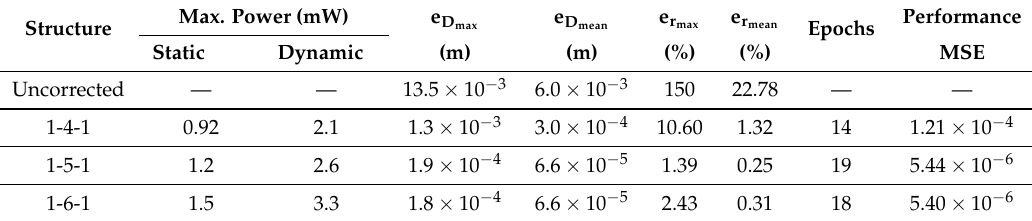
Table 3. Comparative summary of the three ANN structures for the non-linear characteristic NL2 . Structure